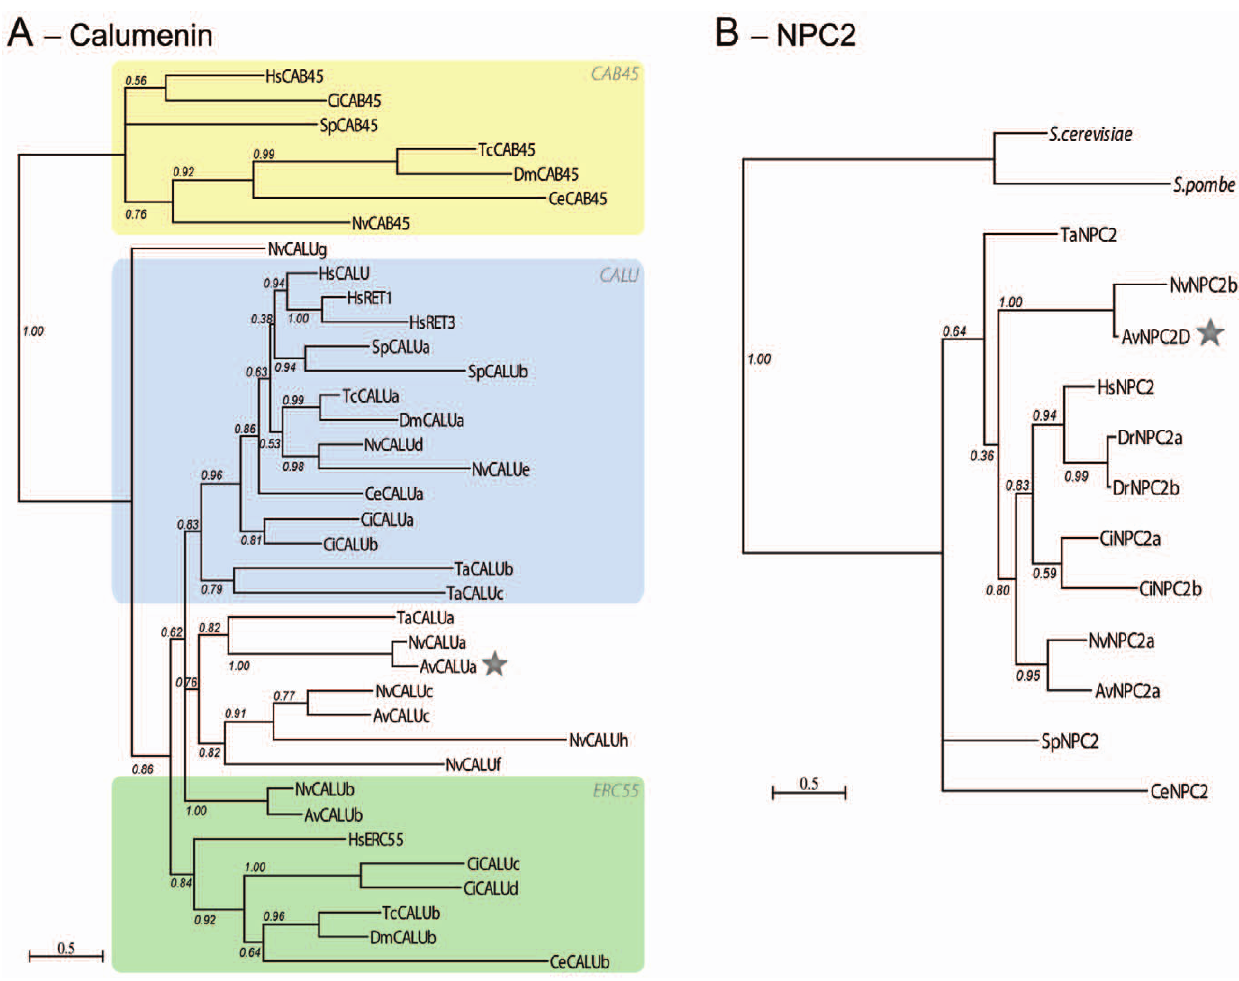
Figure 6. Gene duplication of NPC2 and Calumenin in anthozoans. Calumenin (A) and NPC2 (B) homologs alignments (Figure S5 and S6) were subjected to PhyML maximum likelihood phylogenetic analyses. Best-fitted substitution models were: [LG + I + G + F; I=0.029 F=empirical and gamma=1.127] for Calumenin and [WAG + I + G; I=0.036 and gamma=5.836] for NPC2. Hs: Human, Dr: Danio rerio , Ci: Ciona intestinalis , Sp, Strongylocentrotus purpuratus , Tc: Tribolium castaneum , Dm: Drosophila melanogaster , Ce: Caenorhabditis elegans , Nv: Nematostella vectensis , Av: Anemonia viridis , Ta: Trichoplax adherans , S.cerevisiae and S.pombe: NPC2 homologs in Saccharomyces cerevisiae (Q12408) and Schizosaccharomyces pombe (Q9C0X9), respectively. Protein sequences are given in Table S4. The star points to the A.viridis isoform belonging to the Kern that